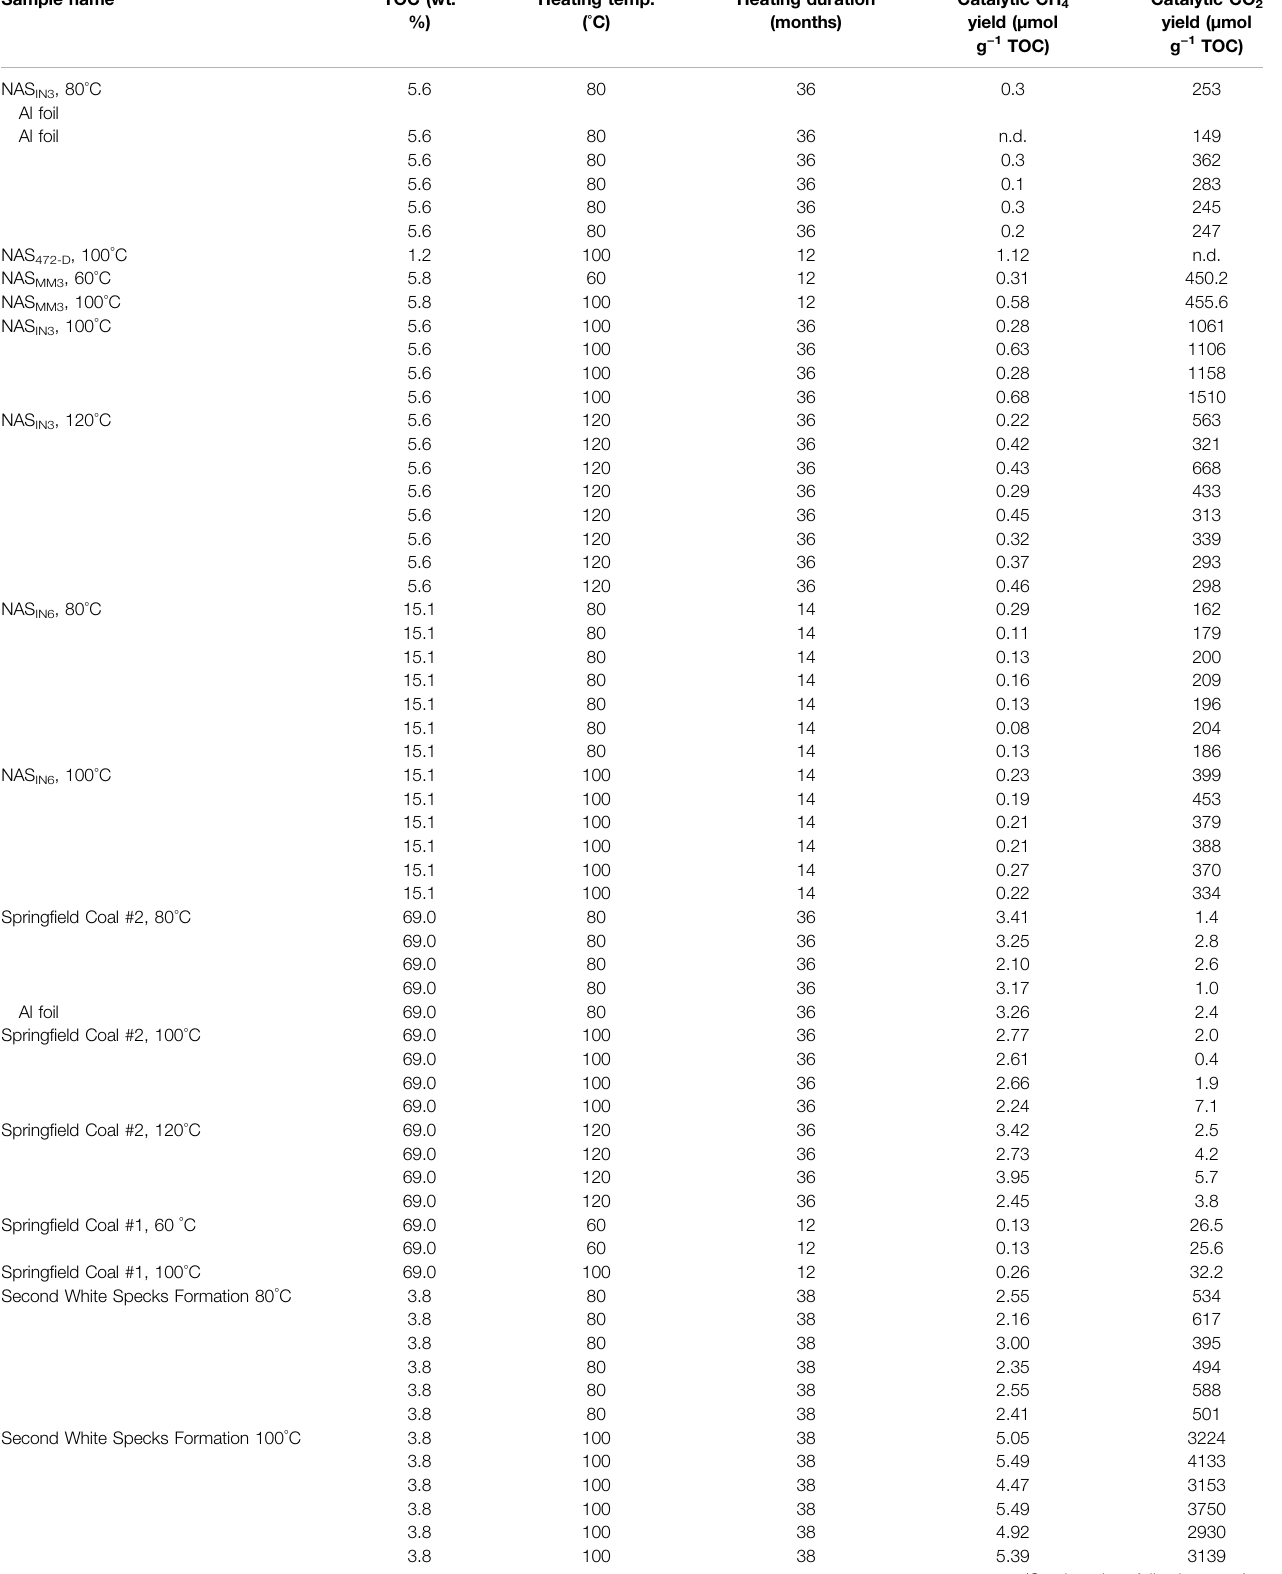
TABLE 3 | Yields of methane and CO 2 generated catalytically at 60, 80, 100, 120, and 140 ° C after months of heating